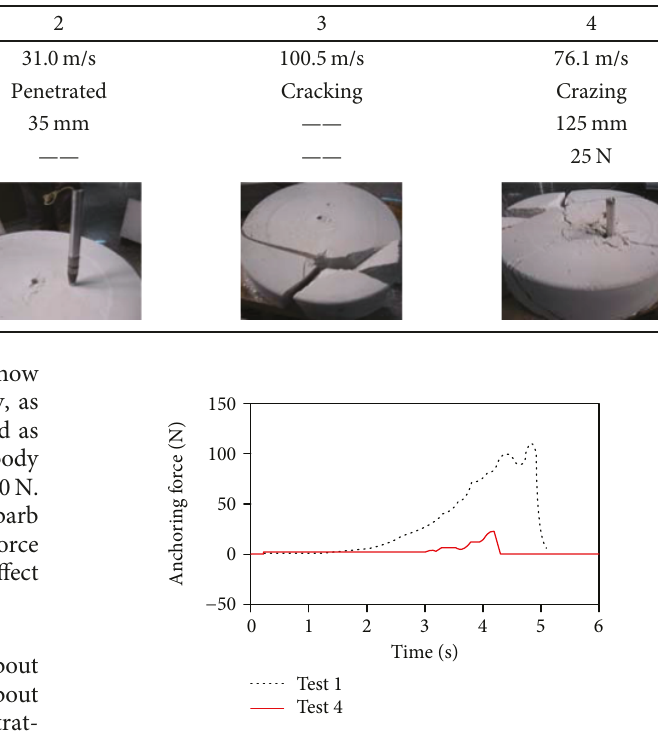
Figure 18: Anchoring force curves of the anchor body in gypsum